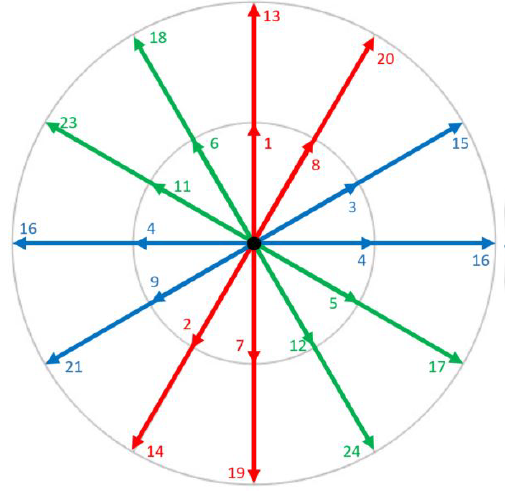
Figure 7. Star of slot 14th MMF